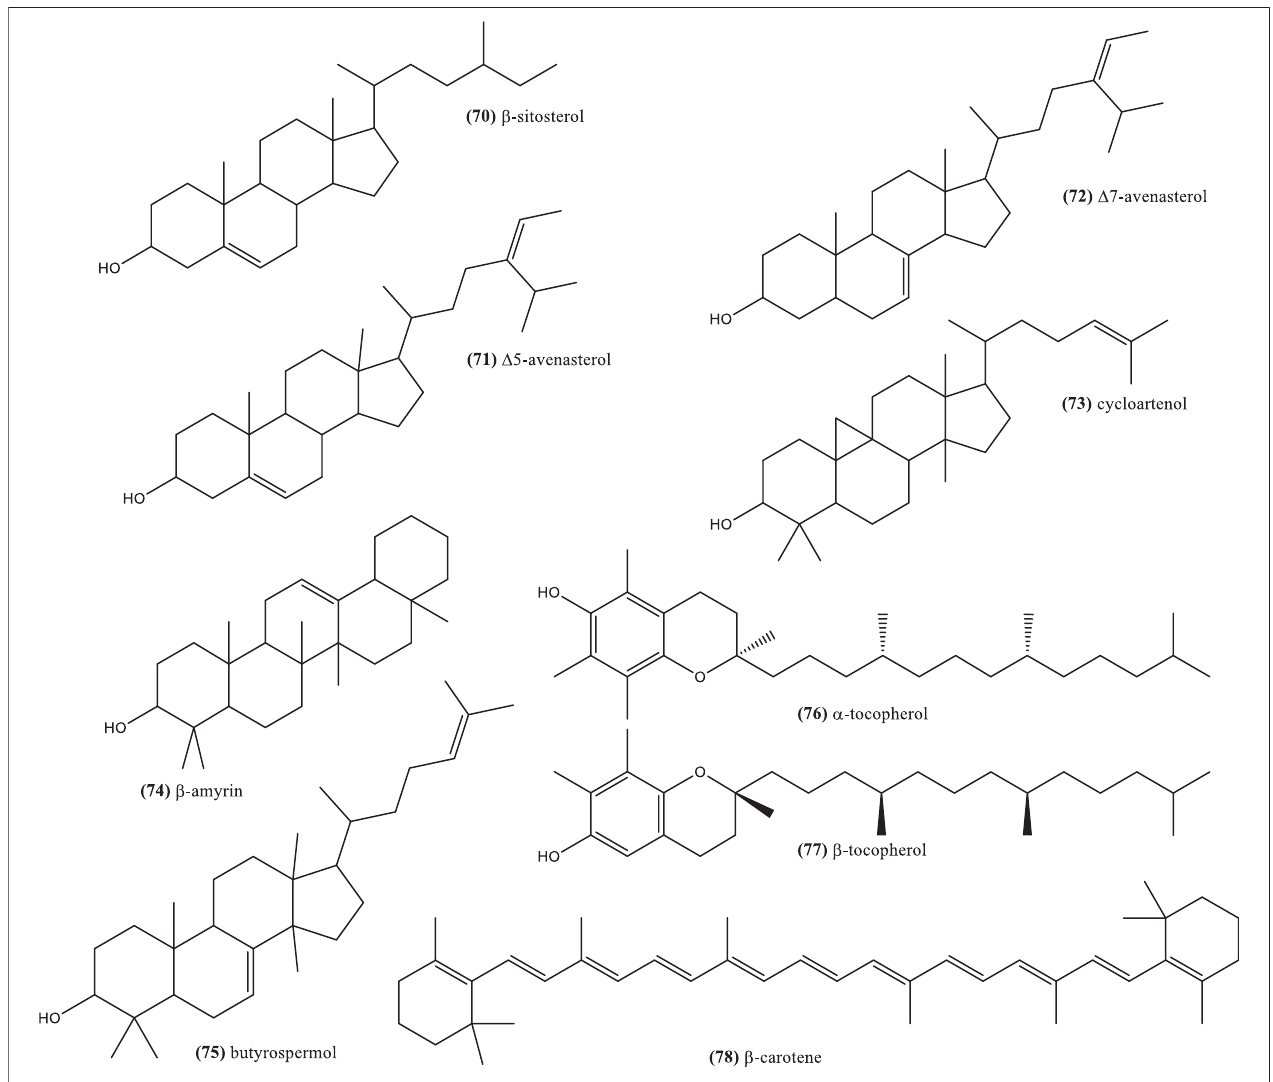
FIGURE 5 | Example of phytosterols and stanols reported and other terpenes in Nigella .